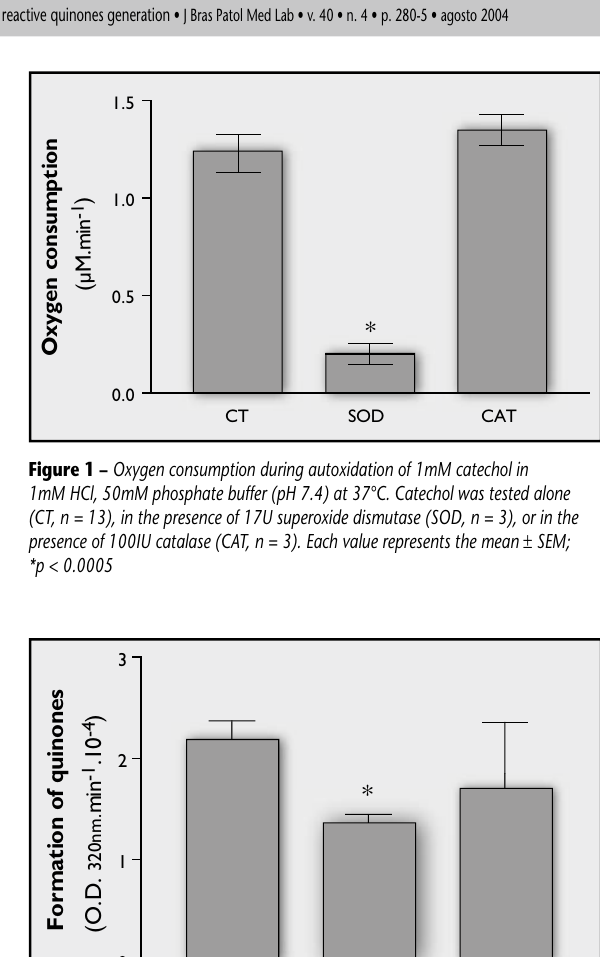
�� Figure 2 – Formation of quinones during autoxidation of 1mM catechol in 1mM HCl, 50mM phosphate buffer (pH 7.4). Catechol was tested alone (CT, n = 6), in the presence of 17U superoxide dismutase (SOD, n = 4), or 100IU catalase (CAT, n = 3). Each value represents the mean ± SEM; *p < 0.05